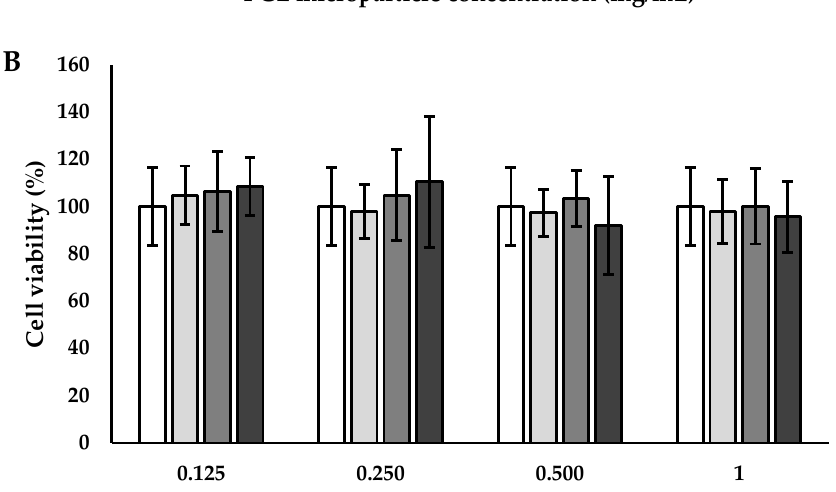
Figure 9. Cell viability of endothelial cells grown for ( A ) 24, ( B ) 48, and ( C ) 72 h in the presence of PCL MPs. PCL: poly(ε -caprolactone).